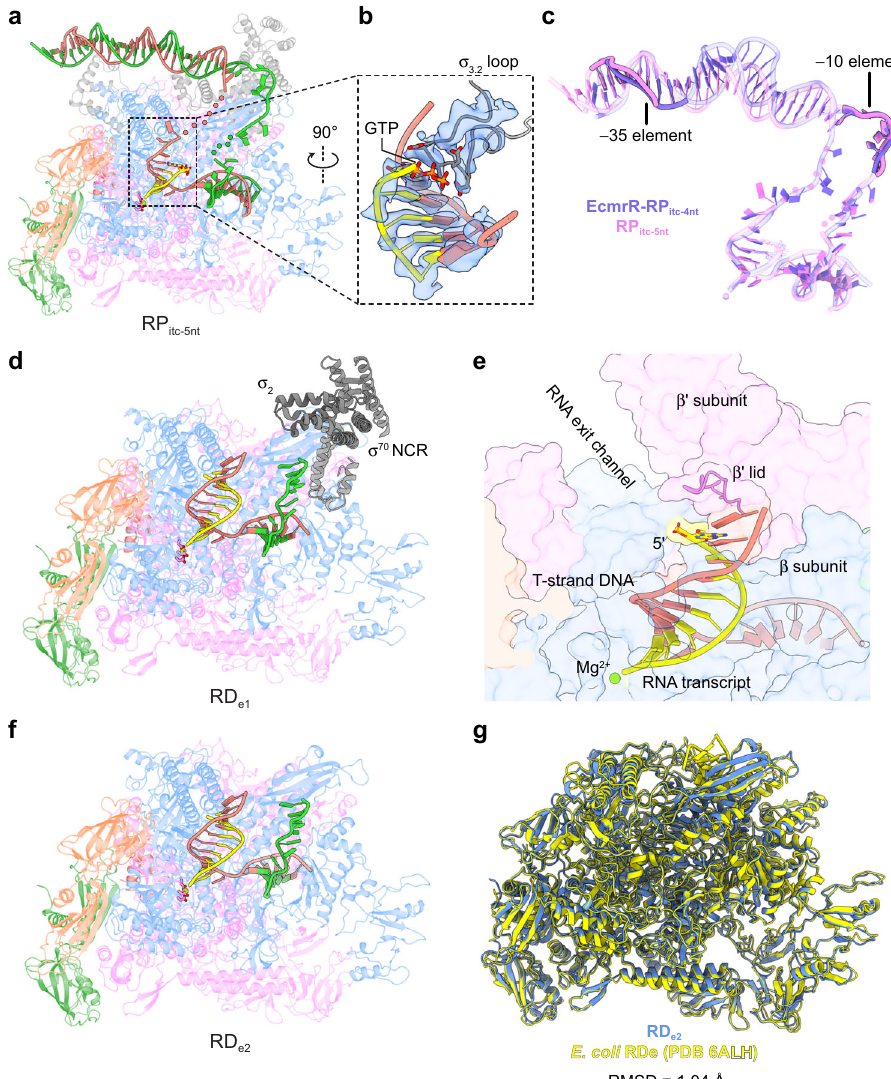
Fig. 5 Promoter escape and elongation complex formation during EcmrR-dependent transcription. a Overall cryo-EM structure of RP itc-5nt . The color schemes for Fig. 5a, b, d – f are the same as in Fig. 3. The 5 ’ -end GTP in the nascent RNA transcript and three catalytic aspartate residues ( β ' D460, β ' D462 and β ' D464) in the polymerase active center are shown as sticks. The Mg 2 + ions are shown as green spheres. Disordered nucleotides in the transcription bubble region are indicated as salmon and green circles for T-strand and NT-strand, respectively. b A close-up view of the 5-nt RNA transcript and σ 3.2 loop. The RNA 5 ’ -end GTP and residues in the σ 3.2 loop acidic tip are shown as sticks. The σ 3.2 loop and RNA-DNA duplex are superimposed with their cryo-EM densities (blue surfaces) contoured at 4 σ . c Comparison of the promoter DNA conformations in EcmrR-RP itc-4nt and RP itc-5nt . Disordered nucleotides in the transcription bubble region of RP itc-5nt are indicated as violet fi lled circles. The − 10 elements on NT-strands and − 35 elements on T-strands in the two structures are highlighted and labeled. d Overall cryo-EM structure of RD e1 . e The 5 ’ -end nucleotide (shown as sticks) of the 9-nt RNA transcript in RD e structures reaches β ' lid and is positioned at the entrance of RNA exit channel. f Overall cryo-EM structure of RD e2 . g Superimposition of RD e2 with previously determined E. coli RD e structure (PDB